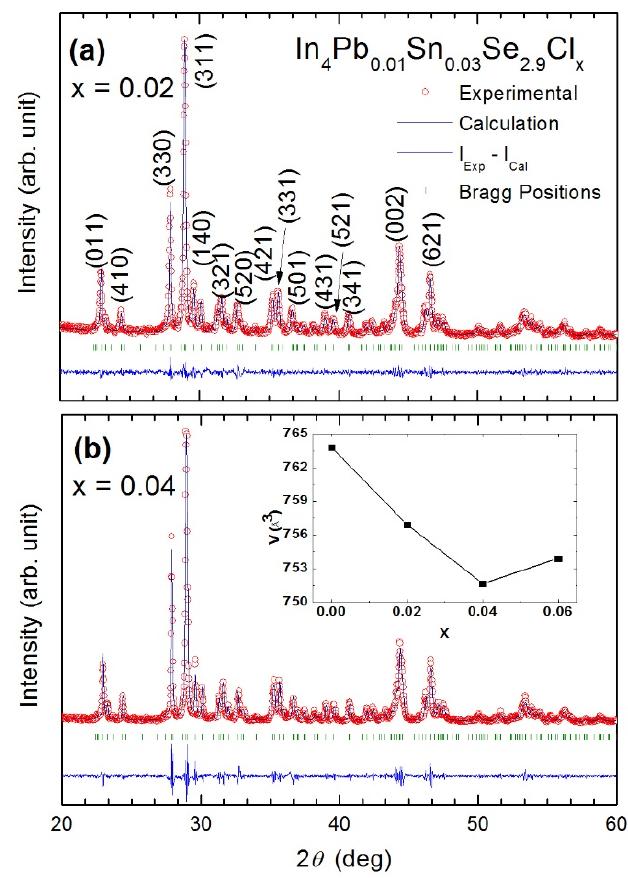
Figure 22. Powder X-ray diffraction profiles of In 4 Pb 0.01 Sn 0.03 Se 2.9 Cl x polycrystalline compounds ( a ) x = 0.02 and ( b ) x = 0.04. Reliability factors (R-factor) obtained from the